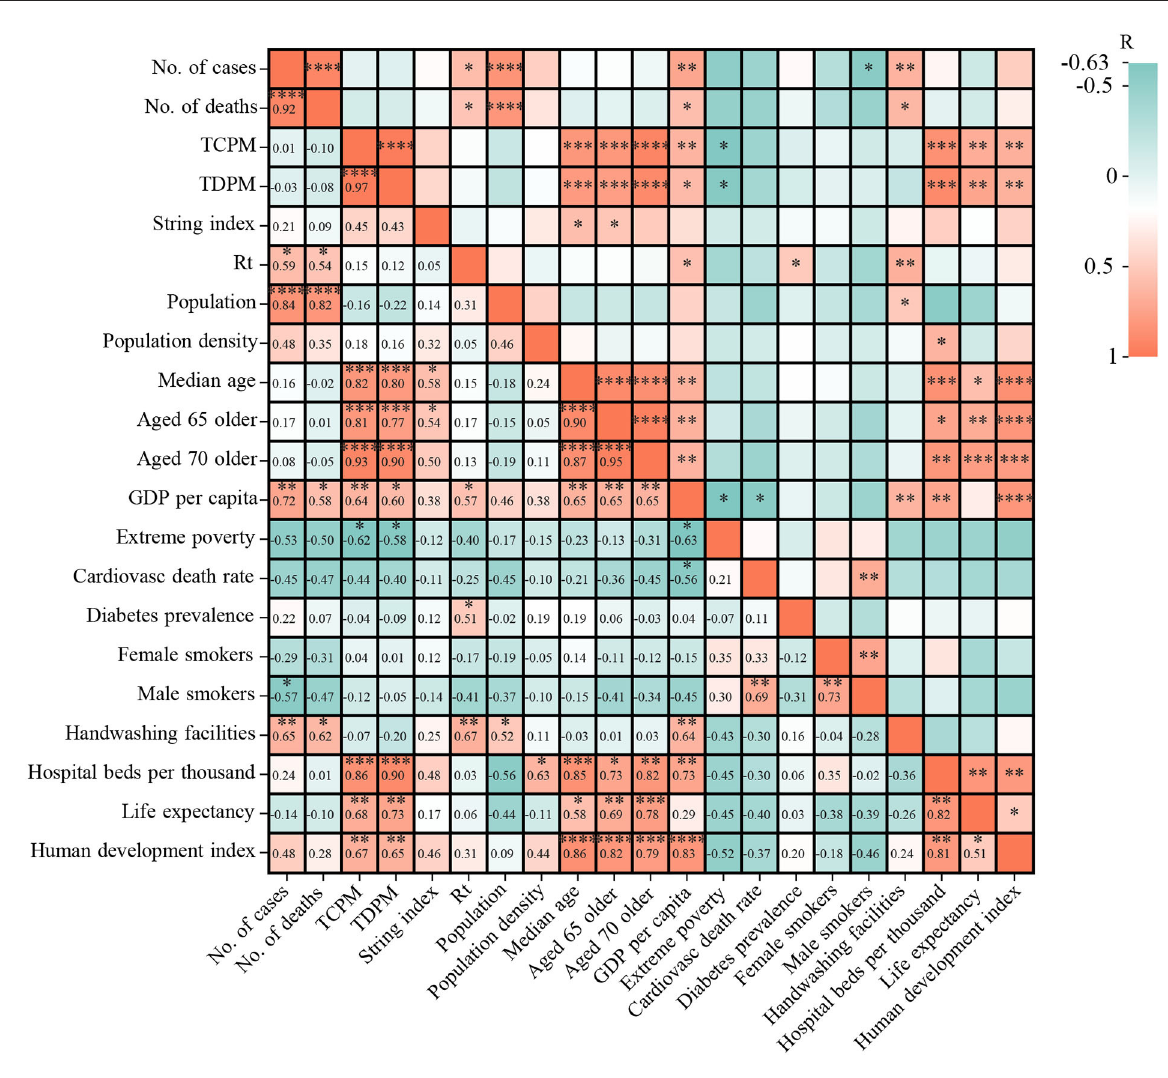
FIGURE5 The correlation between epidemics indexes (cases and deaths) and 17 sociodemographic factors. Note: TCPM, total of cases per million; TDPM, total of deaths per